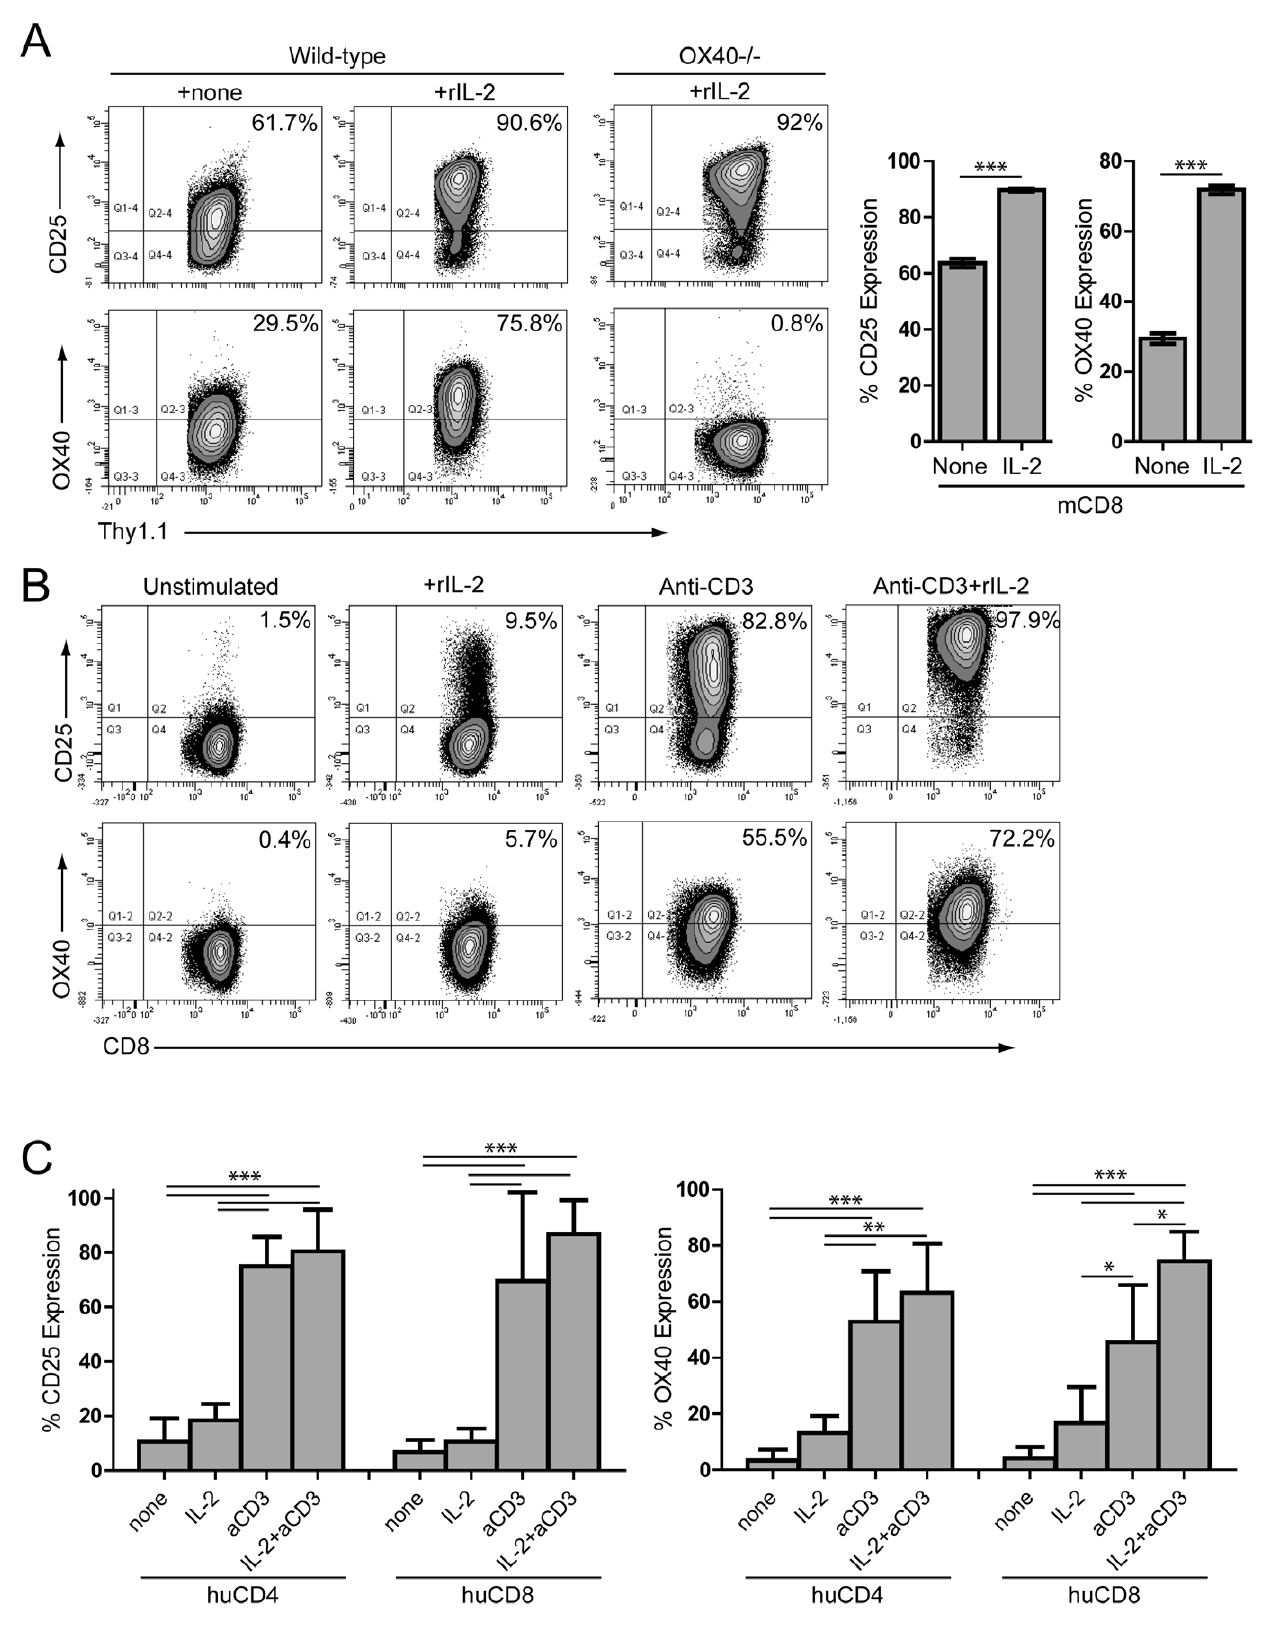
Figure 2. OX40 is regulated on murine and human T cells by TCR stimulation and IL-2. A ) Purified naı¨ve wild-type or OX40 2 / 2 OT-I T cells (1 6 10 6 /ml) were stimulated with peptide-pulsed APCs (6 6 10 6 /ml). Two days later, OT-I T cells were harvested and re-cultured (5 6 10 5 cells/ml) + / 2 rmIL-2 (100 ng/ml). Twenty-four hours later, cells were harvested and the extent of CD25 and OX40 expression were determined. Bar graphs depict